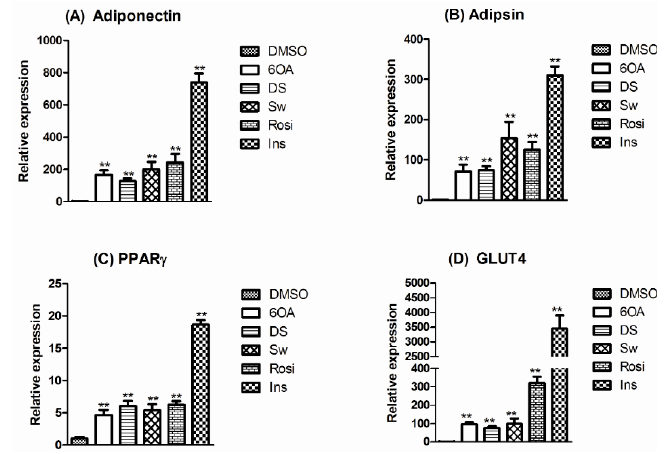
Figure 5. The analysis of PPAR γ and selected adipogenic gene expression in differentiated 3T3-L1 adipocyte cells with quantitative RT-PCR. The expression was measured at 7 days after the treatment of cells with DMSO, 2 µM 6OA, 2 µM DS, 2 µM Sw, 50 nM rosiglitazone or 1 μ M insulin. ( A ) Adiponectin;